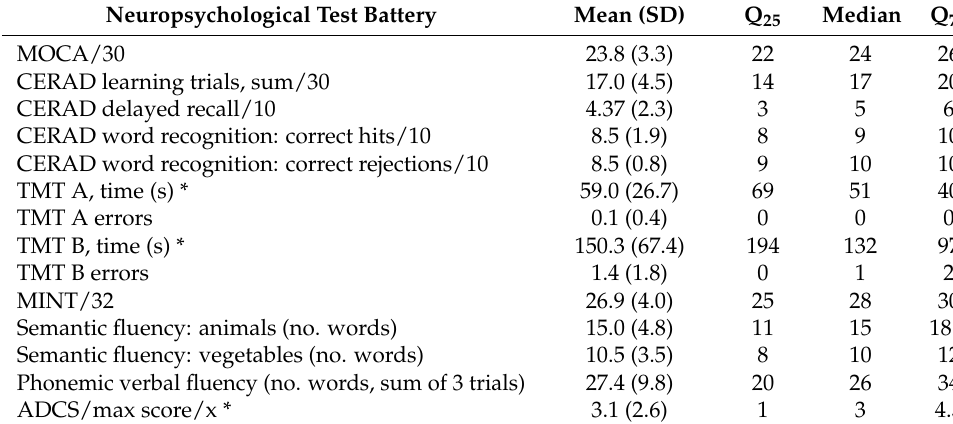
Table 2. Summary statistics of neuropsychological test scores.